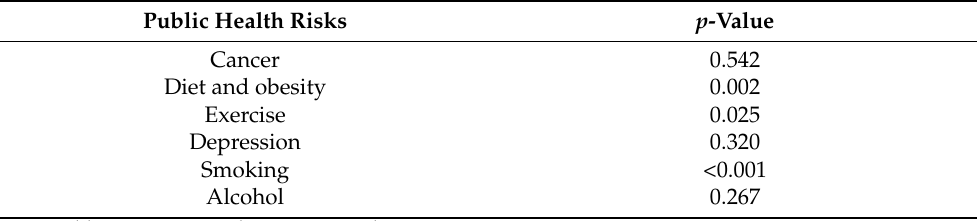
Table 6. Chi-square tests regarding importance of public health risks by smoking status (importance defined as “Very important”, “Moderately important”, “Slightly important”, “Not important”, “Do not know/No